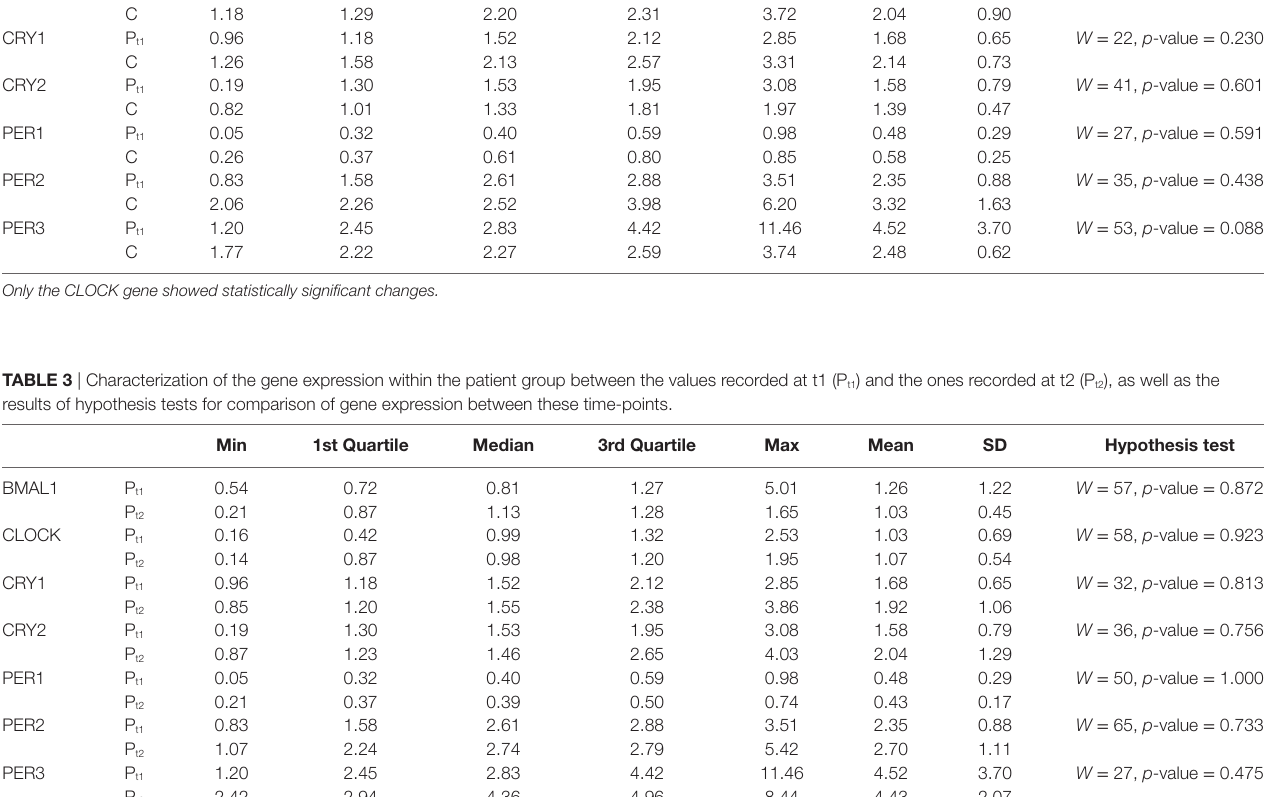
TaBle 2 | Characterization of the gene expression between the control group (C) and the patient group at t1 (P t1 ), as well as the results of hypothesis tests for comparison of gene expression between these groups. Min 1st Quartile Median 3rd Quartile Max Mean sD hypothesis test BMAL1 P t1 0.54